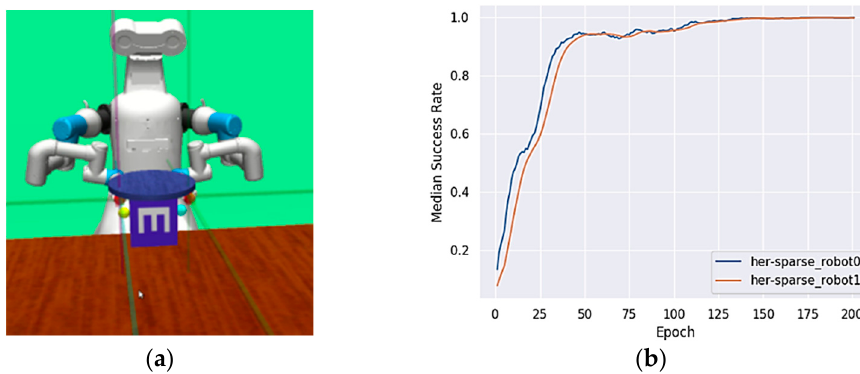
Figure 5. Gripping pot scene. The purpose of this task is to verify the performance of the algorithm. ( a ) A circle protrudes from the top of the object. The robot can touch a reasonable point to grip the pot and put the pot in a specified area. ( b ) The learning curve begins to oscillate with a small amplitude and finally converges to the optimal solution. The abscissa is the number of training rounds and the ordinate is the average success rate of 10 tests.